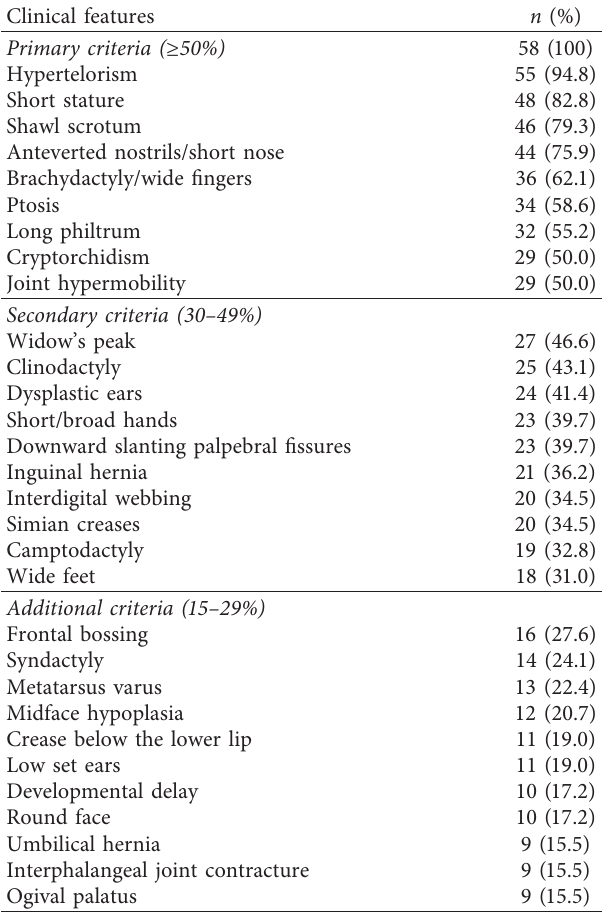
Figure 2: (a) Frontal view of a patient with severe expressions (image courtesy of Orrico et al. [38]). (b) Lateral view of a patient with severe expressions (image courtesy of Orrico et al. [38]). Table 3: Summarization of clinical features reclassified according to their